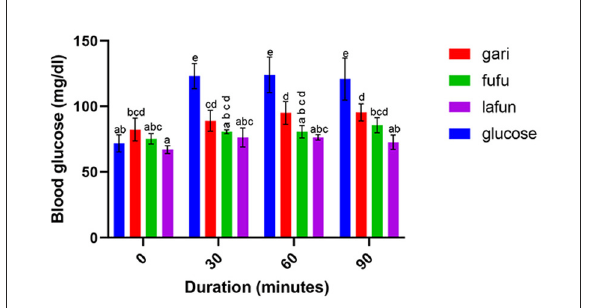
FIGURE3 Blood glucose response after the intake of fufu, lafun and gari from IITA-TMS-IBA182961. Mean values with different letters are significantly different at p < 0.05.